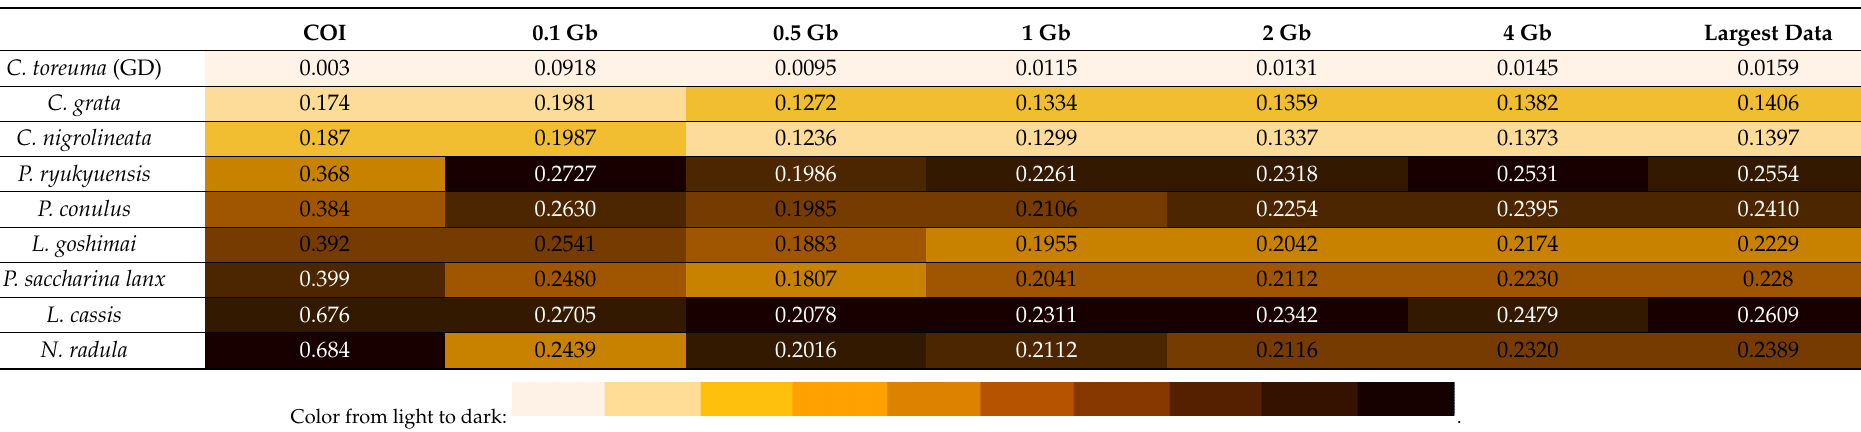
Color from light to dark: . Table 3. The calculation distance from COI and different sizes of genome skims between S. flexuosa and reference species in our study. Color shows the distance ranking between reference species and query species, that is, the darker the color, the farther the relationship. COI 0.1 Gb